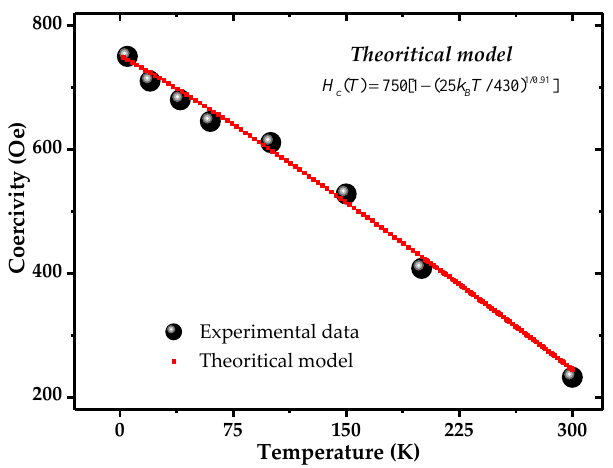
Figure 5. Temperature-dependent coercivity for Ni nanotubes. The red curve shows the fitting curve according to theoretical model discussed in the text.